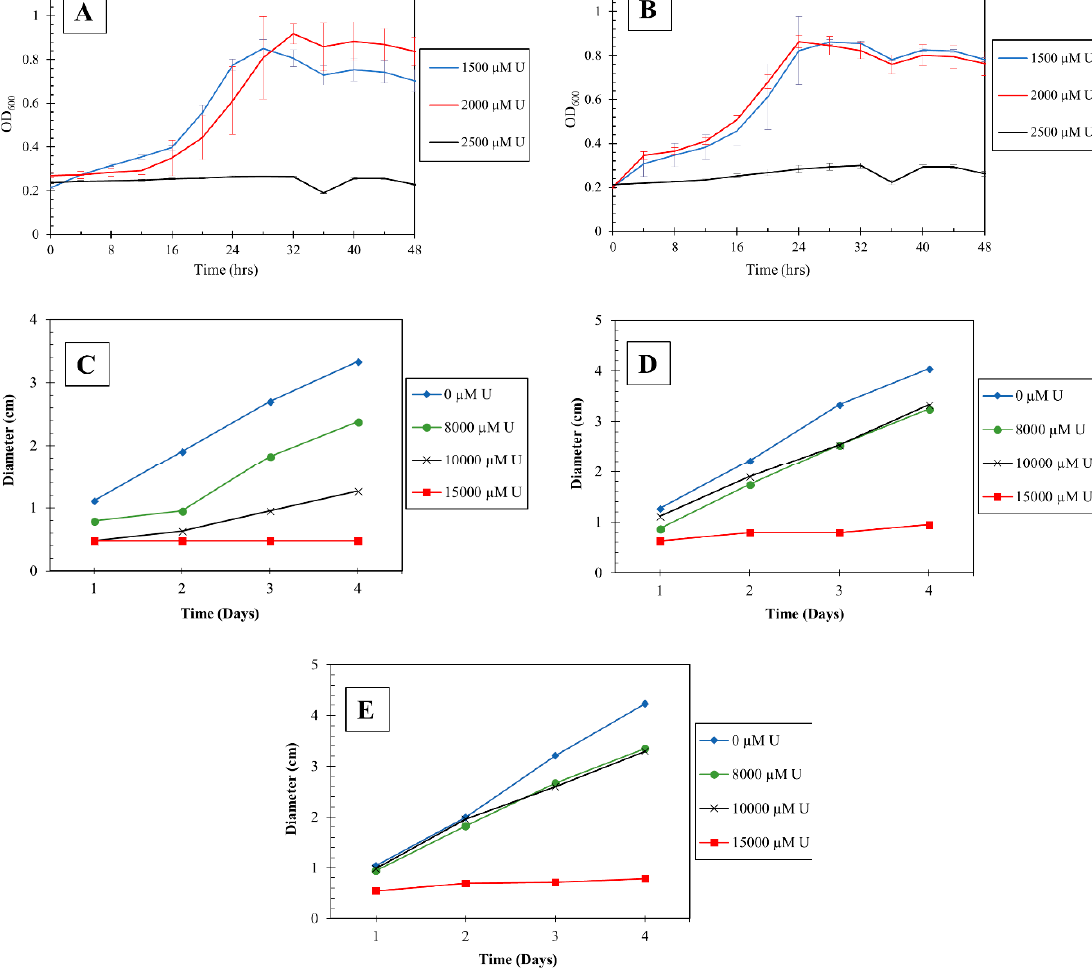
Figure 5. Shown are the growth responses of Burkholderia spp. strain DC2 ( A ) and DC3 ( B ), at different concentrations of uranium. Also shown are the growth responses of Penicillium spp. DC1 ( C ), MT1 ( D ) and MT2 ( E ) at different concentrations of uranium.